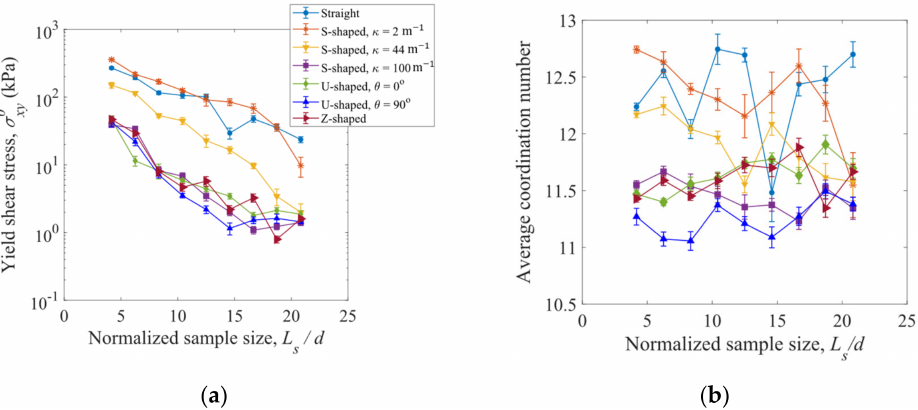
Figure 17. Variation of ( a ) yield shear stress and ( b ) average coordination number with normalized sample size for the fibers of various shapes. The half-length of an error bar represents a standard deviation from the average value at the steady state of shearing